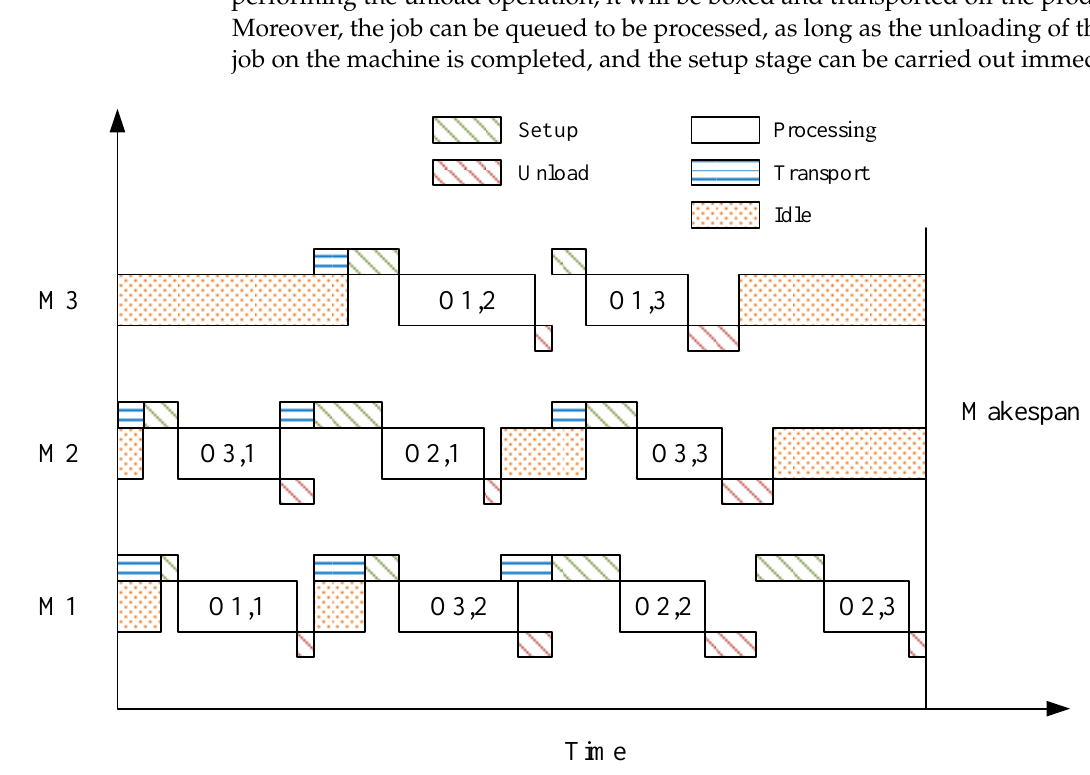
Figure 2. The Gantt chart of the instance mentioned